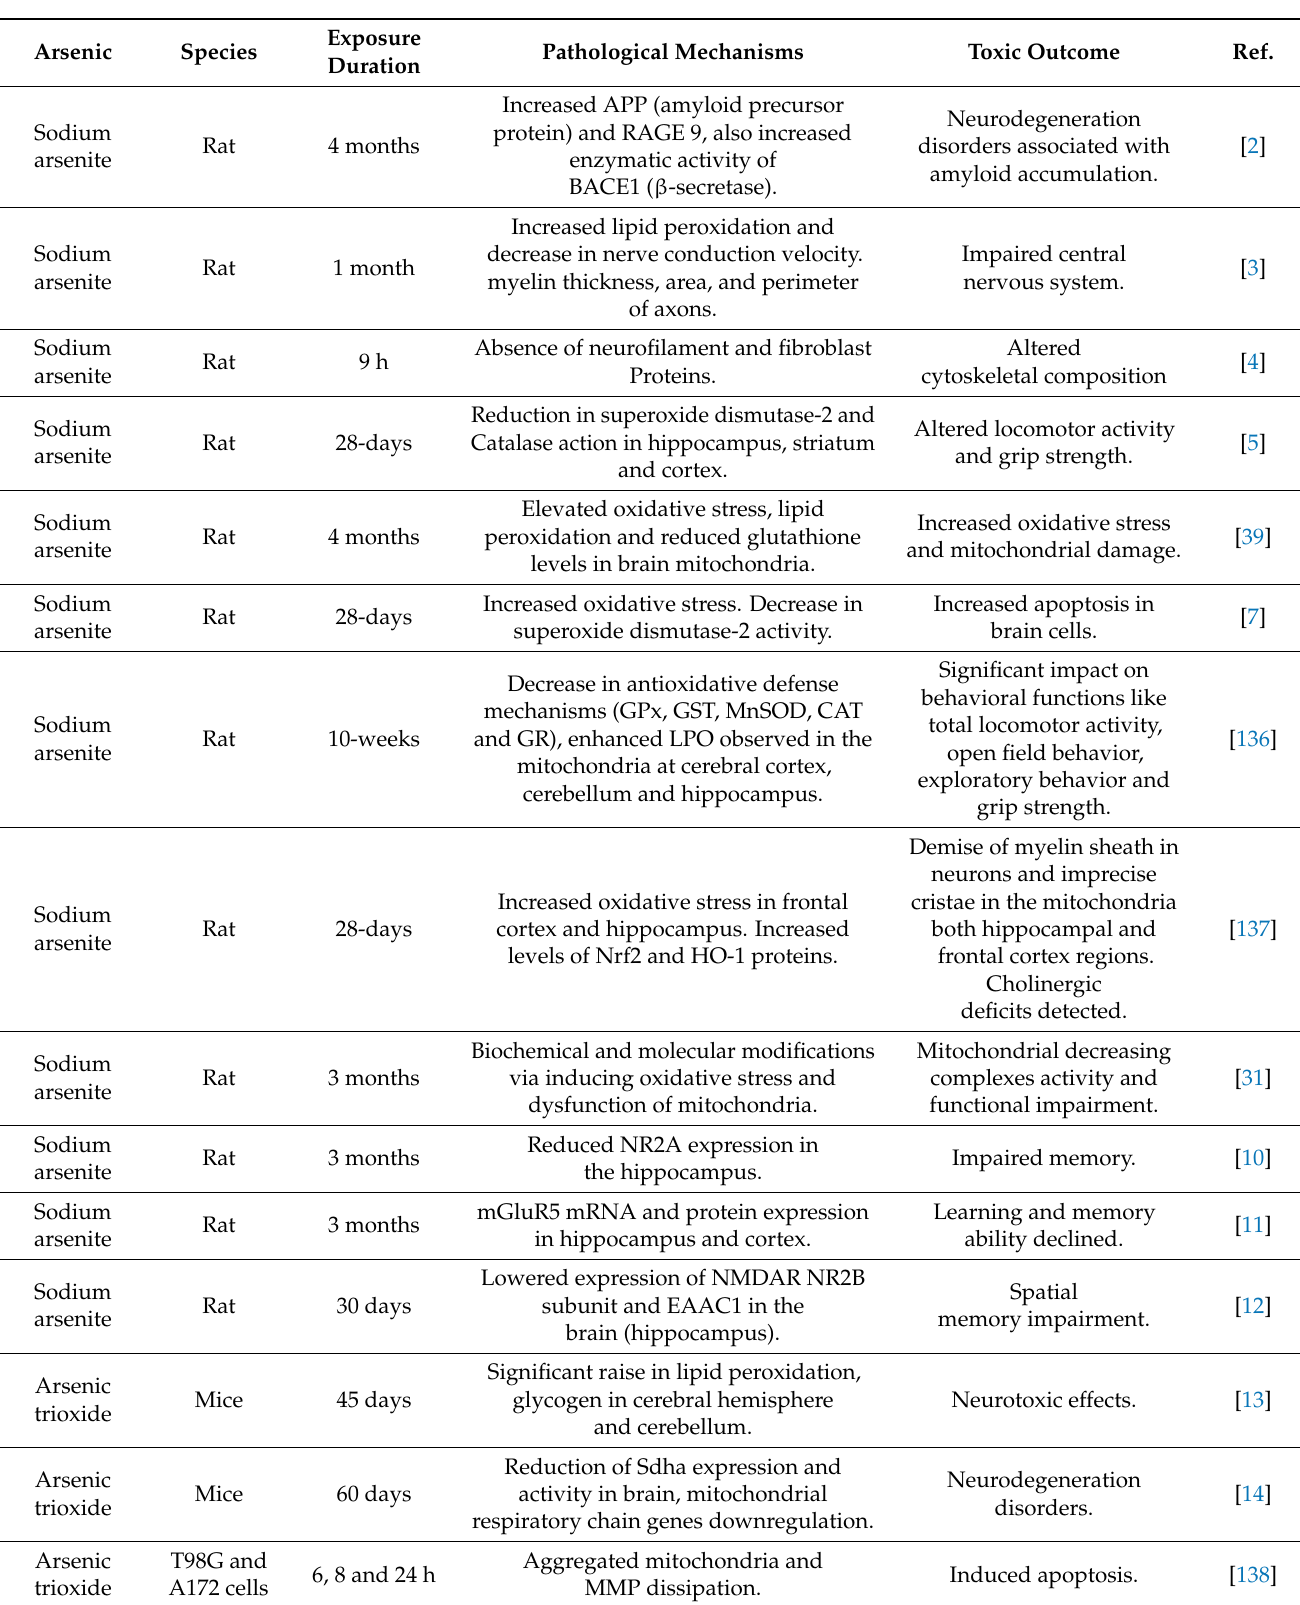
Table 1. In-vitro and in-vivo studies demonstrating mechanisms of arsenic